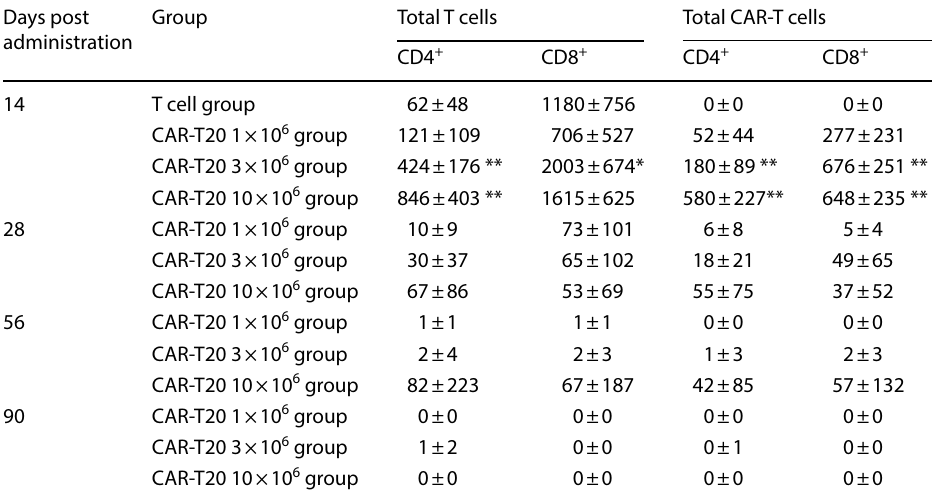
Comparing with T cell group,*p < 0.05, **p <